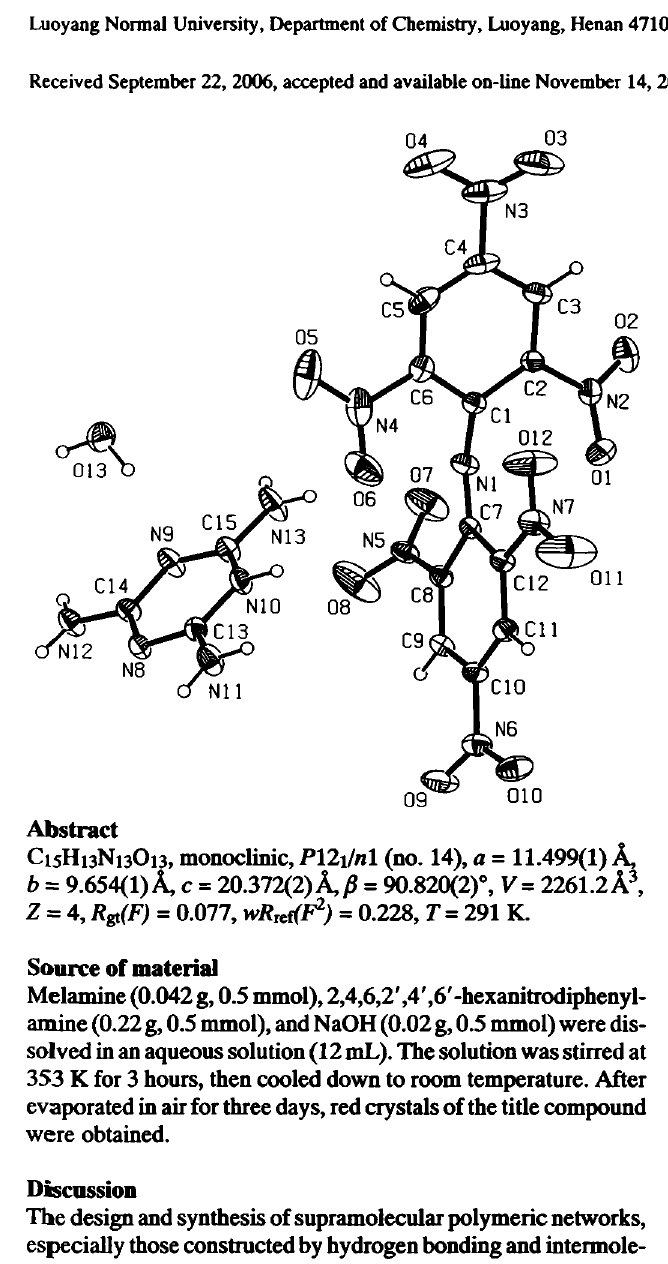
Table 2. Atomic coordinates and displacement parameters (in Ä 2